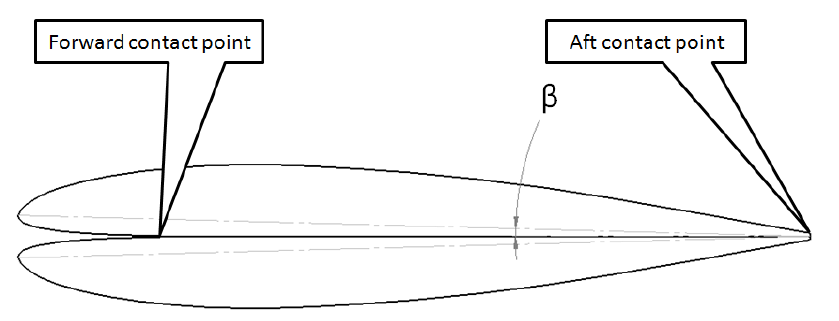
Figure 18. Definition of parameters for thickness reduction method.